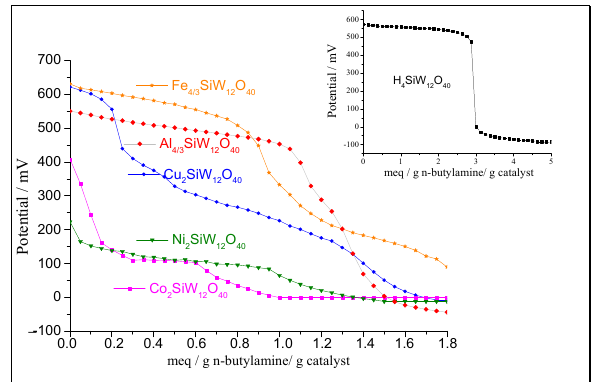
Figure 8. Potentiometric titration curves of silicotungstic acid and their metal-exchanged salts (adapted from ref. [27]).